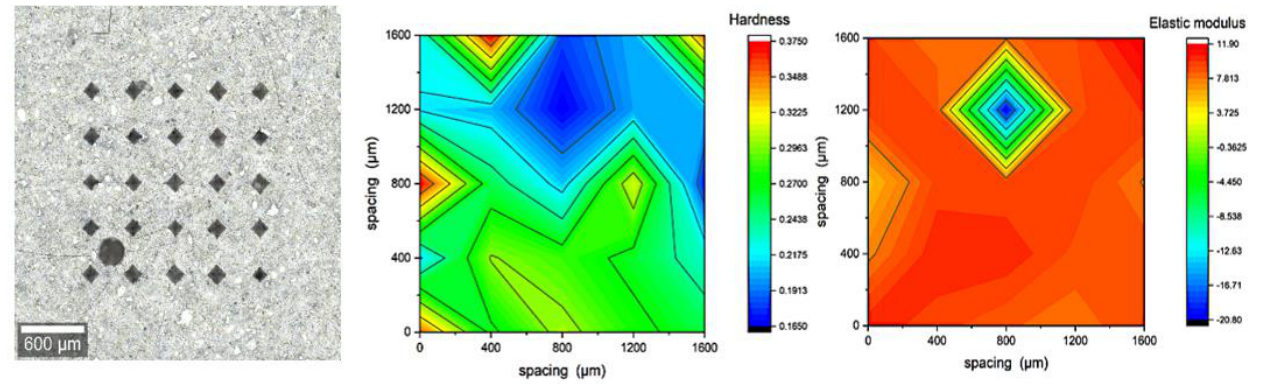
Figure 11. Indentation results for polished cores of 15% ferrierite-added Class-H cement with 25 indents, represented as maps of hardness (avg. of 0.319 GPa) and elastic modulus (avg. of 11.01 GPa).